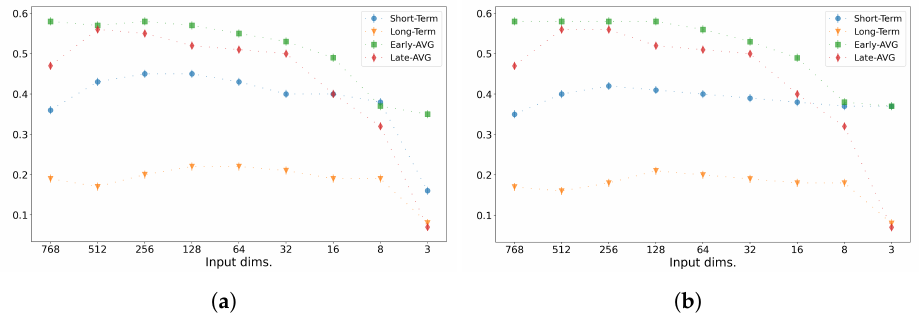
Figure 9. The performance of linear regression models is enhanced when the original SBERT input representation is reduced via PCA, although low dimensionality spaces seem to progressively worsen.